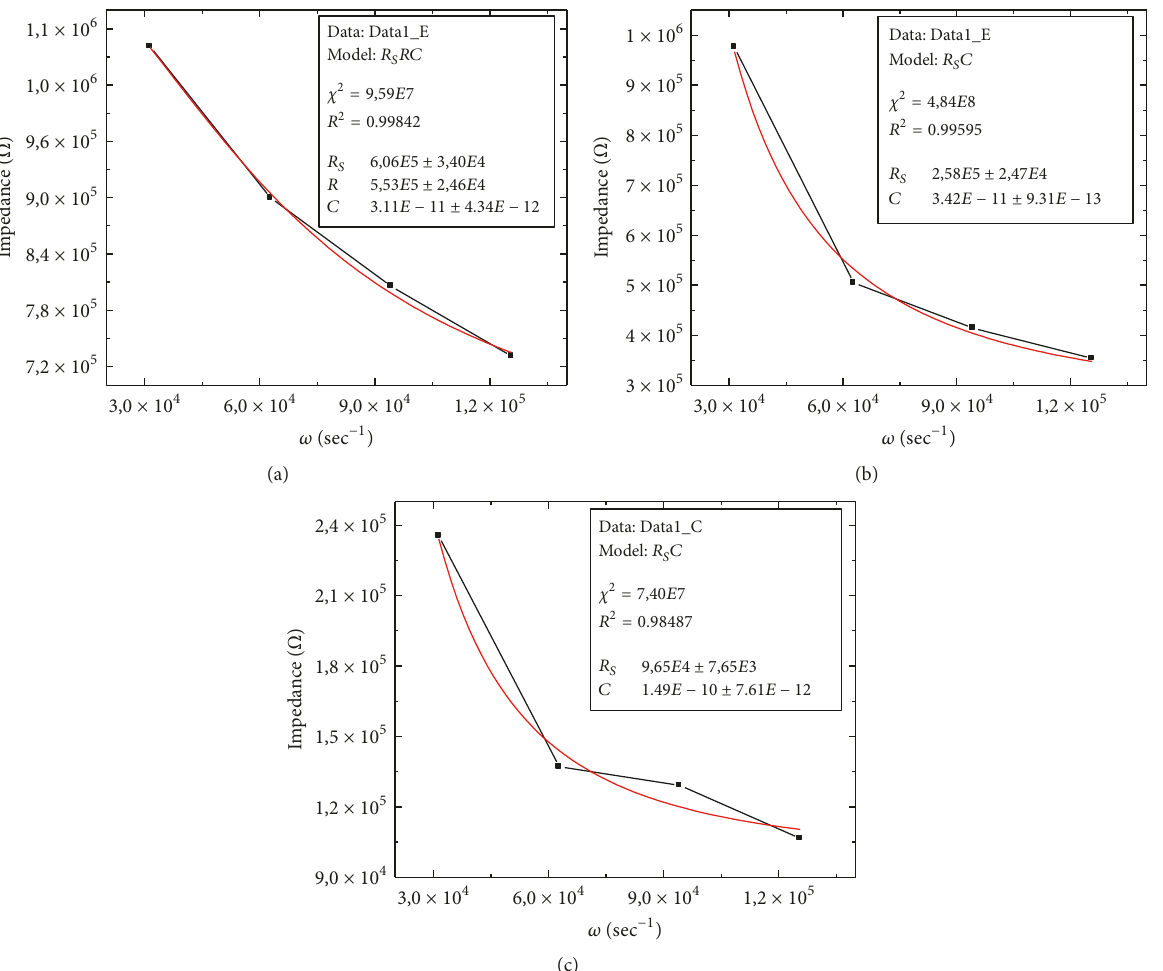
Figure 8: Results of fitting of expressions (2, 3) to experimental data: (a) reverse applied voltage 6V; (b) direct applied voltage 6 V; (c) direct applied voltage